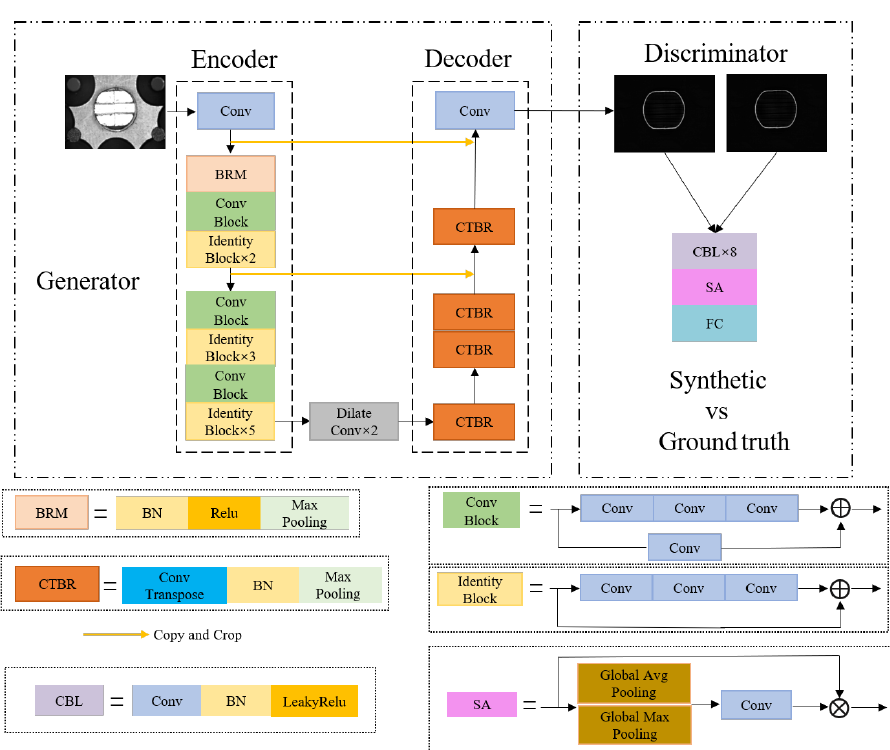
Figure 3. Generative adversarial network structure. The encoder is a feature extraction module, the decoder is a feature reconstruction module, and the discriminator serves as an auxiliary classifier to help the generator generate more realistic labels.